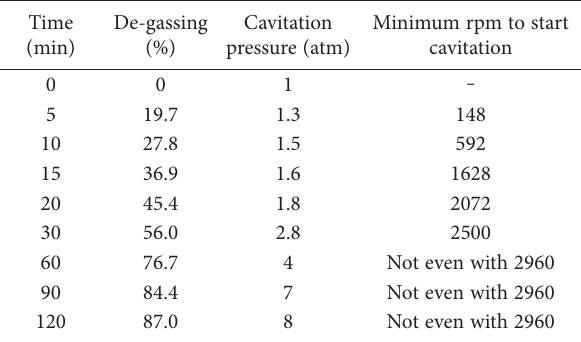
Table 1. Experimental results of the de-gassing effects on cavitation observed for a rotating propeller completely immersed in de-gassed water.